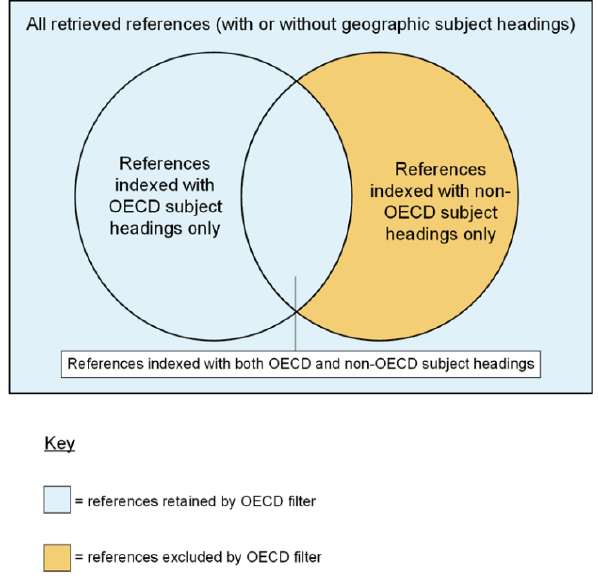
Figure 2 Venn diagram showing the conceptual structure of the OECD countries filters (not to